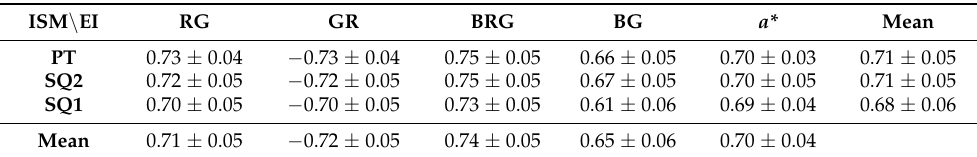
Table 1. Mean and standard deviation (SD) of the Spearman’s correlation coefficients ( r s ) between visual and optical erythema evaluation, relying on different erythema indices (EI: RG– EI RG , GR– EI GR , BRG– EI BRG , BG– EI BG , and a* ) and image-sampling methods (ISM: PT–60 pixels, SQ2–two small squares, SQ1–one big square).